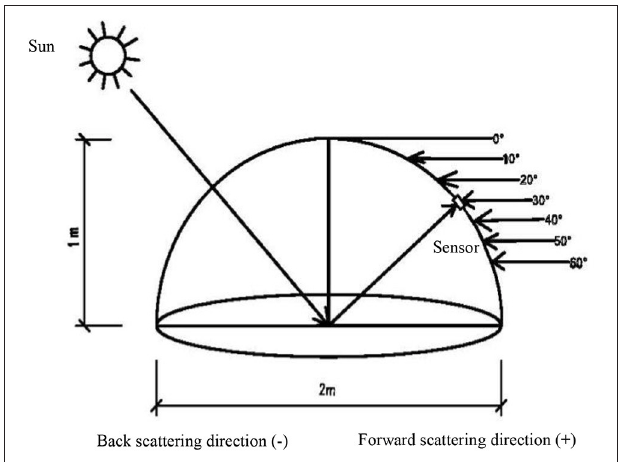
FIGURE 1 | Dimensions and design of Field Goniometer System.